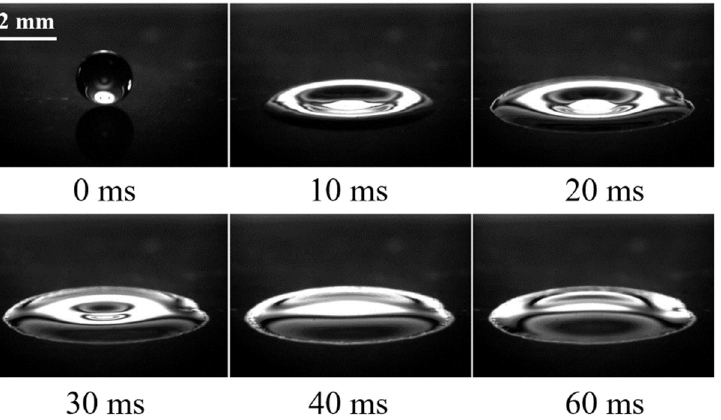
Figure 6. Droplet impact and spreading on the superhydrophilic surface in different stages. Exper- imental conditions: W e = 7.6, T w = 40.0 °C.